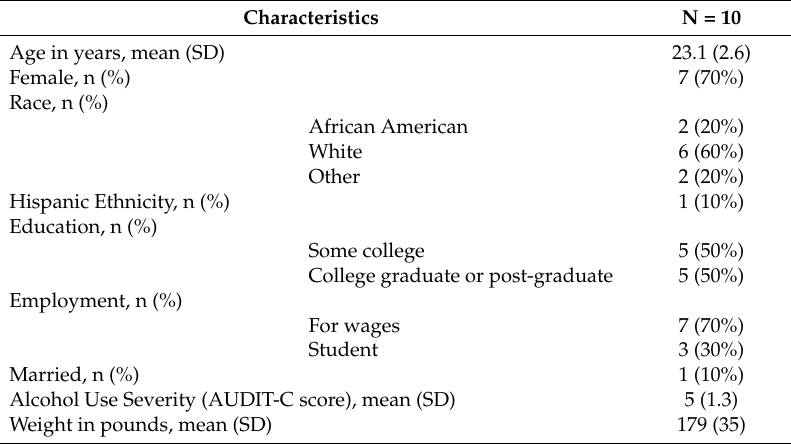
Table 1. Sample descriptive